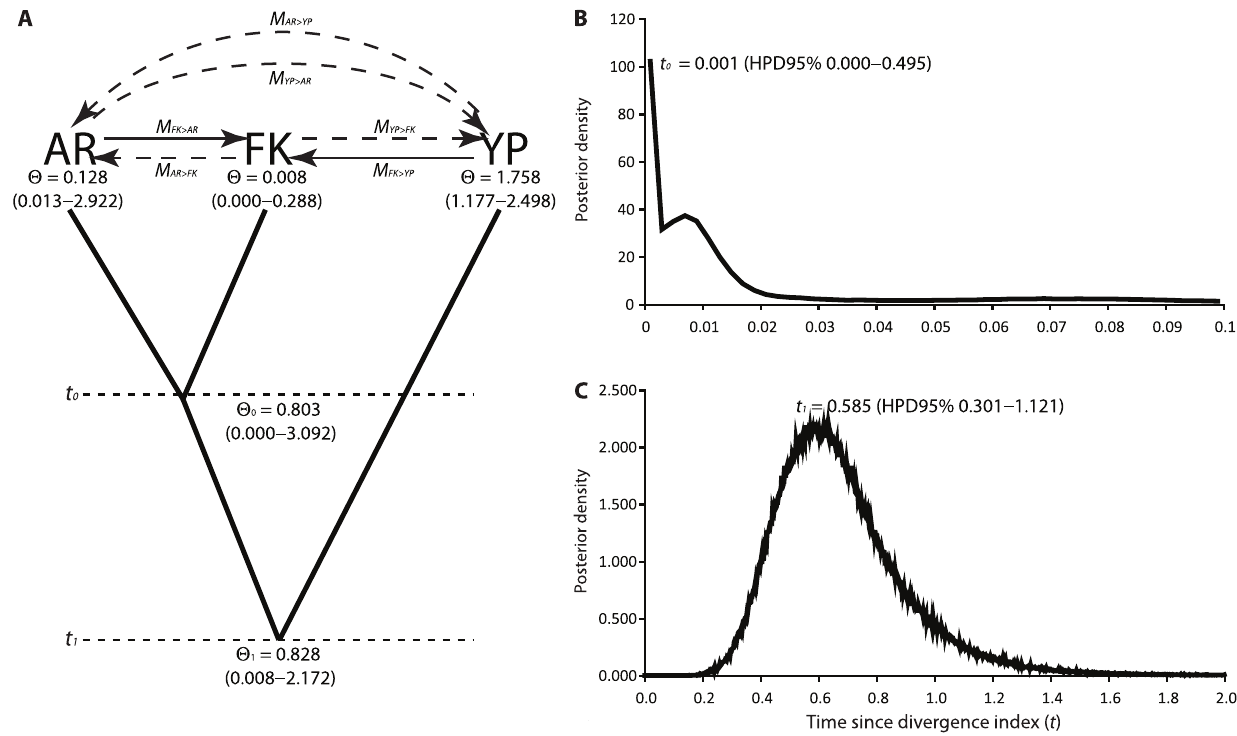
Figure 5. Three-population IMa2 model for speckled teal (AR=Argentina, FK=Falkland Islands) and yellow-billed pintails (YP) for six nuclear loci. A) Effective population size parameter h . B) Time since divergence index ( t ) between speckled teal in the Falkland Islands and Argentina. C) Time since divergence index ( t ) between speckled teal and yellow-billed pintails. The 95% highest posterior densities (HPD) for each parameter are shown in parentheses (see Table 2 for definitions). Arrows depict the six gene flow parameters ( M = m / m ). HPD95% estimates of M that overlap zero are shown with dashed lines (as shown in Figure 4).